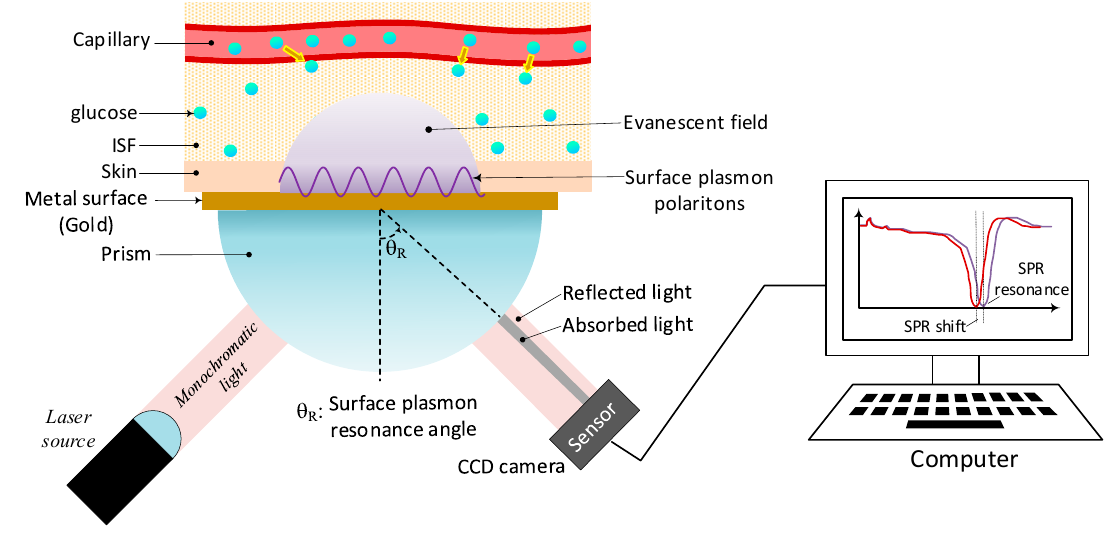
Figure 6. Principle of surface plasmon resonance for glucose monitoring. Table 5. Advantages and disadvantages of Surface plasmon resonance.